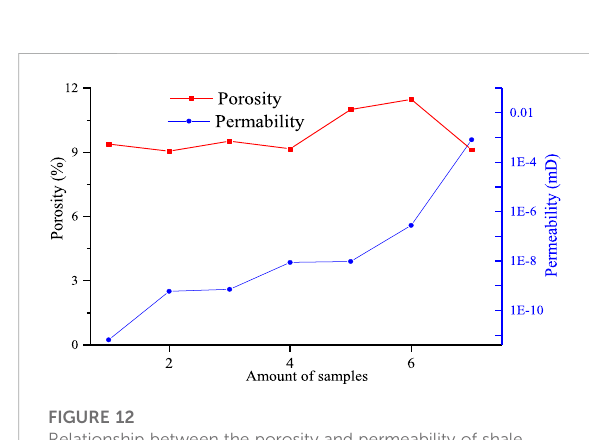
FIGURE 12 Relationship between the porosity and permeability of shale reservoirs in the upper